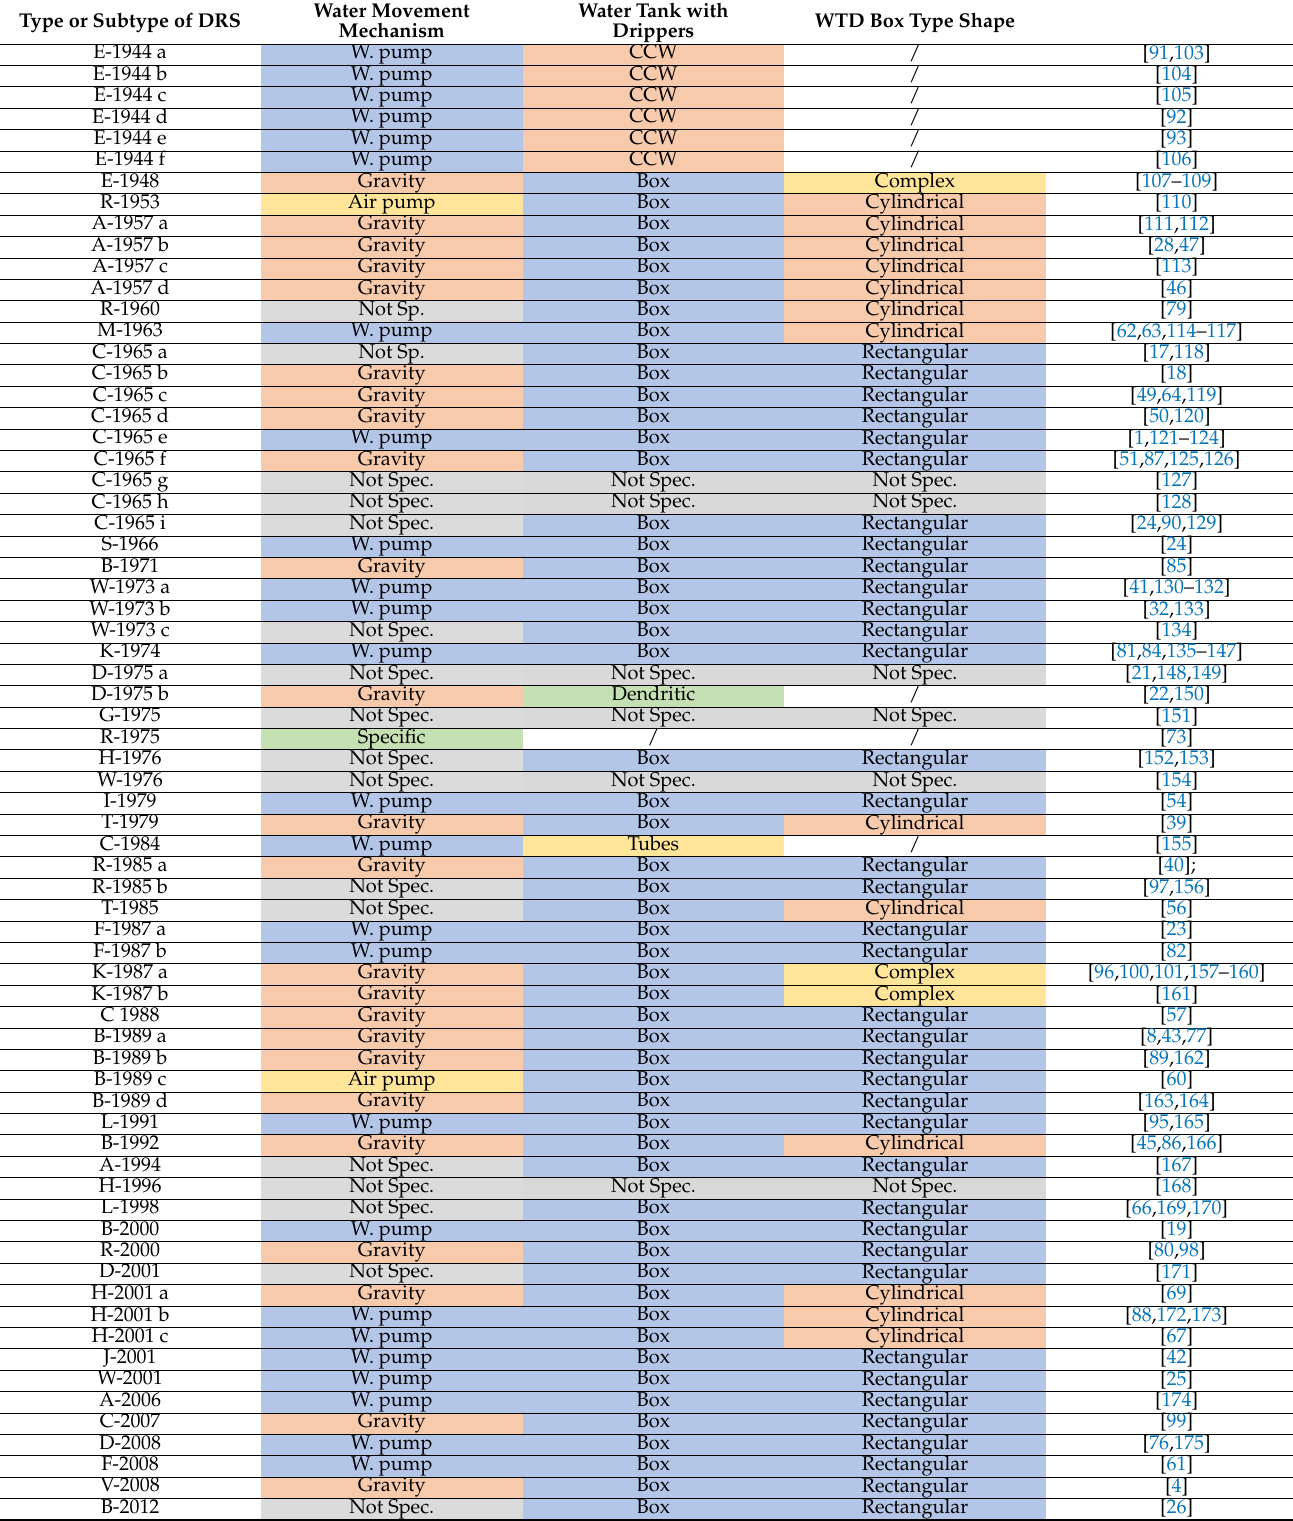
Table 1. Classification of DRS >1 according to water moving mechanism and water tank with drippers type and shape, with listed literature sources of papers in which simulators are described or applied (W. pump—water pump; CCW—cloth on chicken wire; Not Spec.—not specified; WTD—water tank with drippers). Note: background colours signify different groups in a classification table only to make it easier for reader to observe